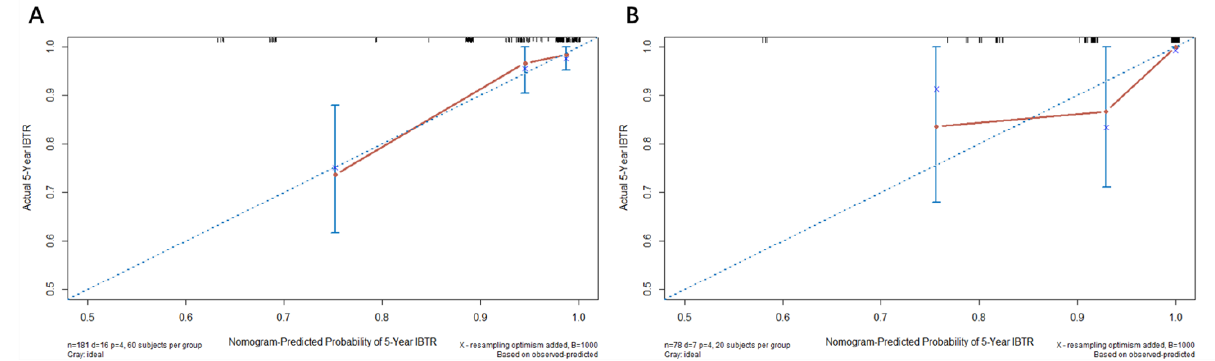
Figure 2. Calibration curves for 5-year IBTR in the training ( A ) and internal validation cohort ( B ). Abbreviations: IBTR = ipsilateral breast tumour recurrence.